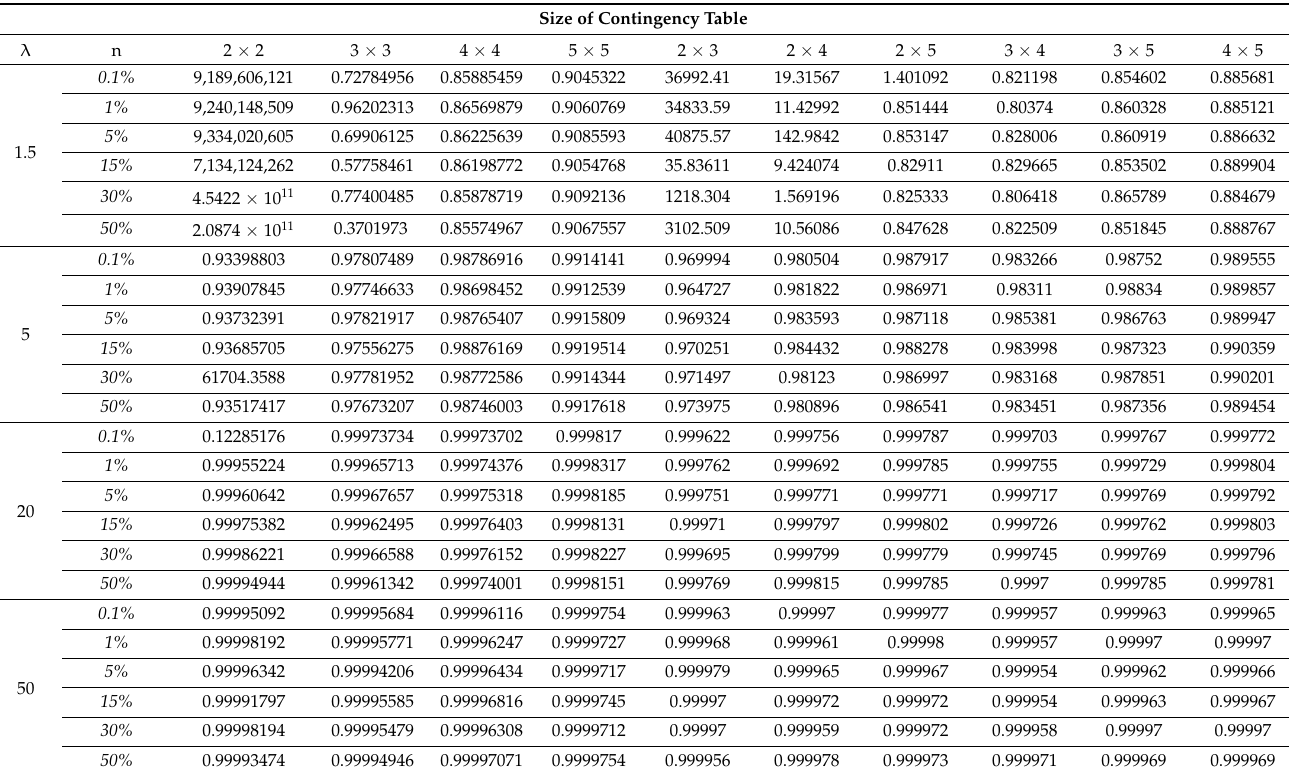
Table 4. Relative efficiencies, RE, of ˆ ϕ LogNI and ˆ ϕ BDNI for varying dimensions and λ s of simulated contingency